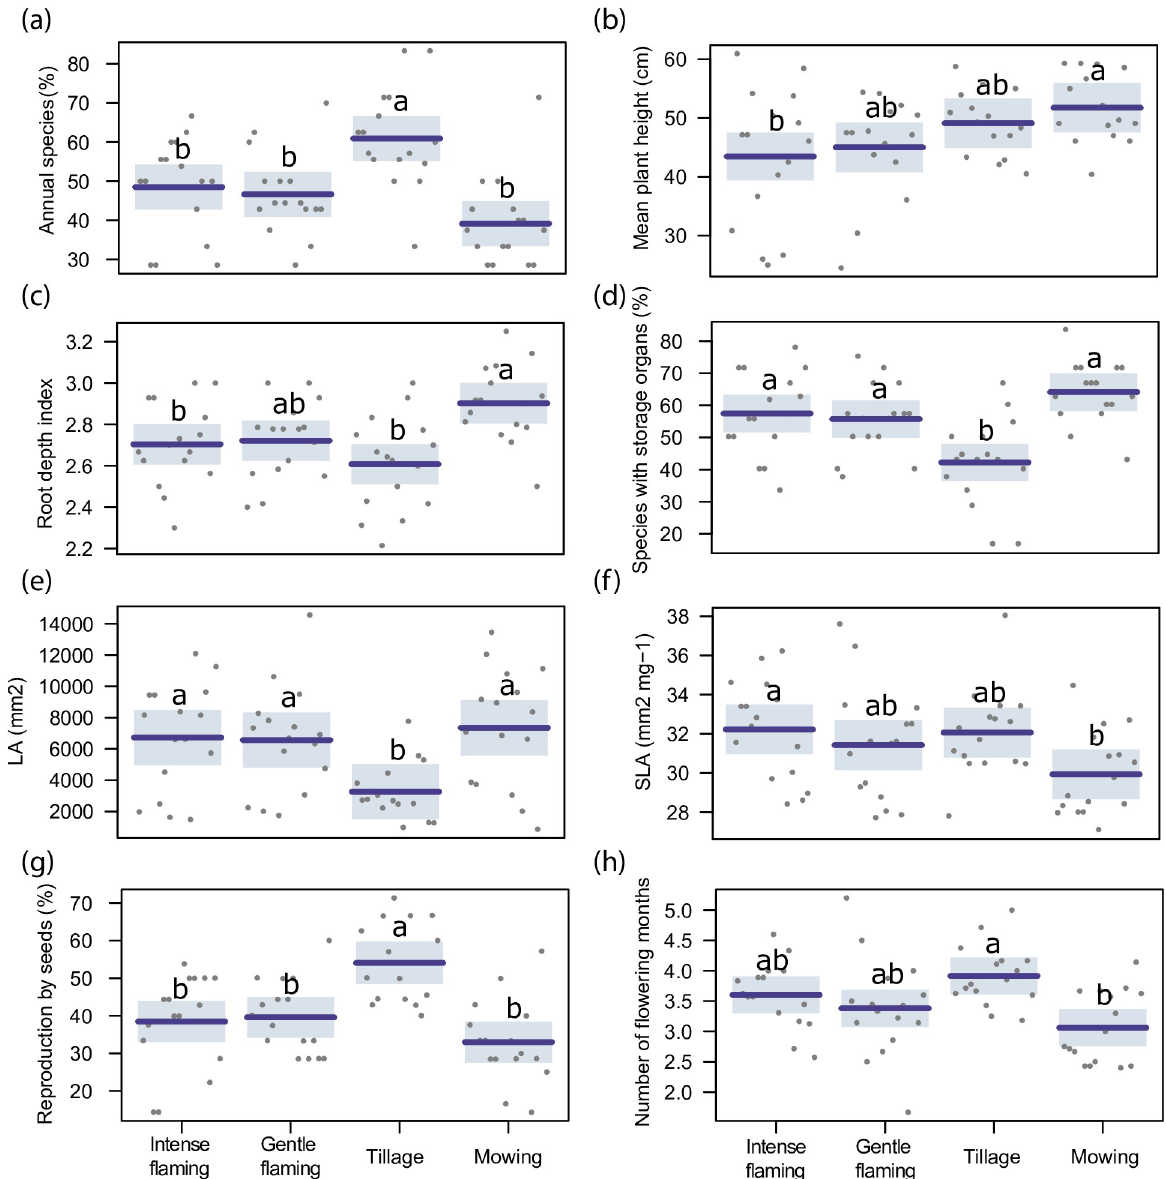
Fig 2. Functional traits results. Comparison between the different applied weed control techniques (intense and gentle flaming, tillage and mowing) regarding annual species frequency (a), plant height (b), root depth index (c), presence of storage organs (d), leaf area (e), specific leaf area (f), reproduction by seed (g), number of flowering months (h). Different letters show significant differences across treatments (p < 0.05), while shade areas are the confidence intervals (95%).